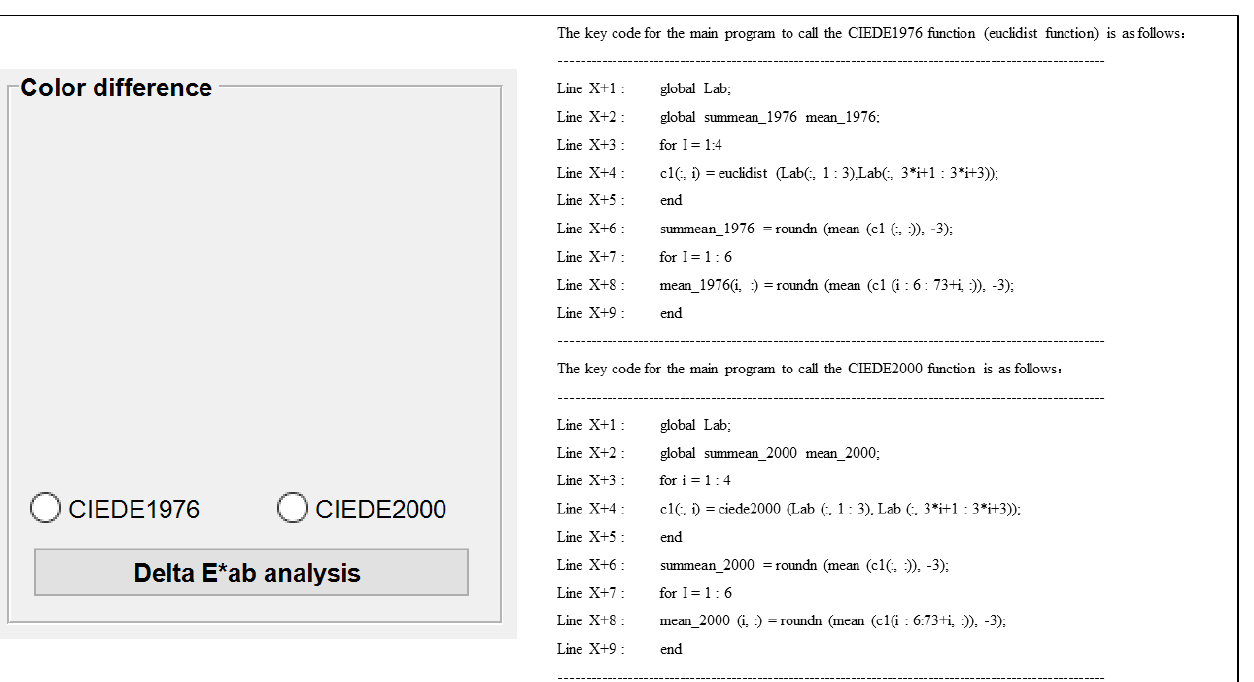
Displaying the corresponding mapping of the image basis solution in the coordinate system